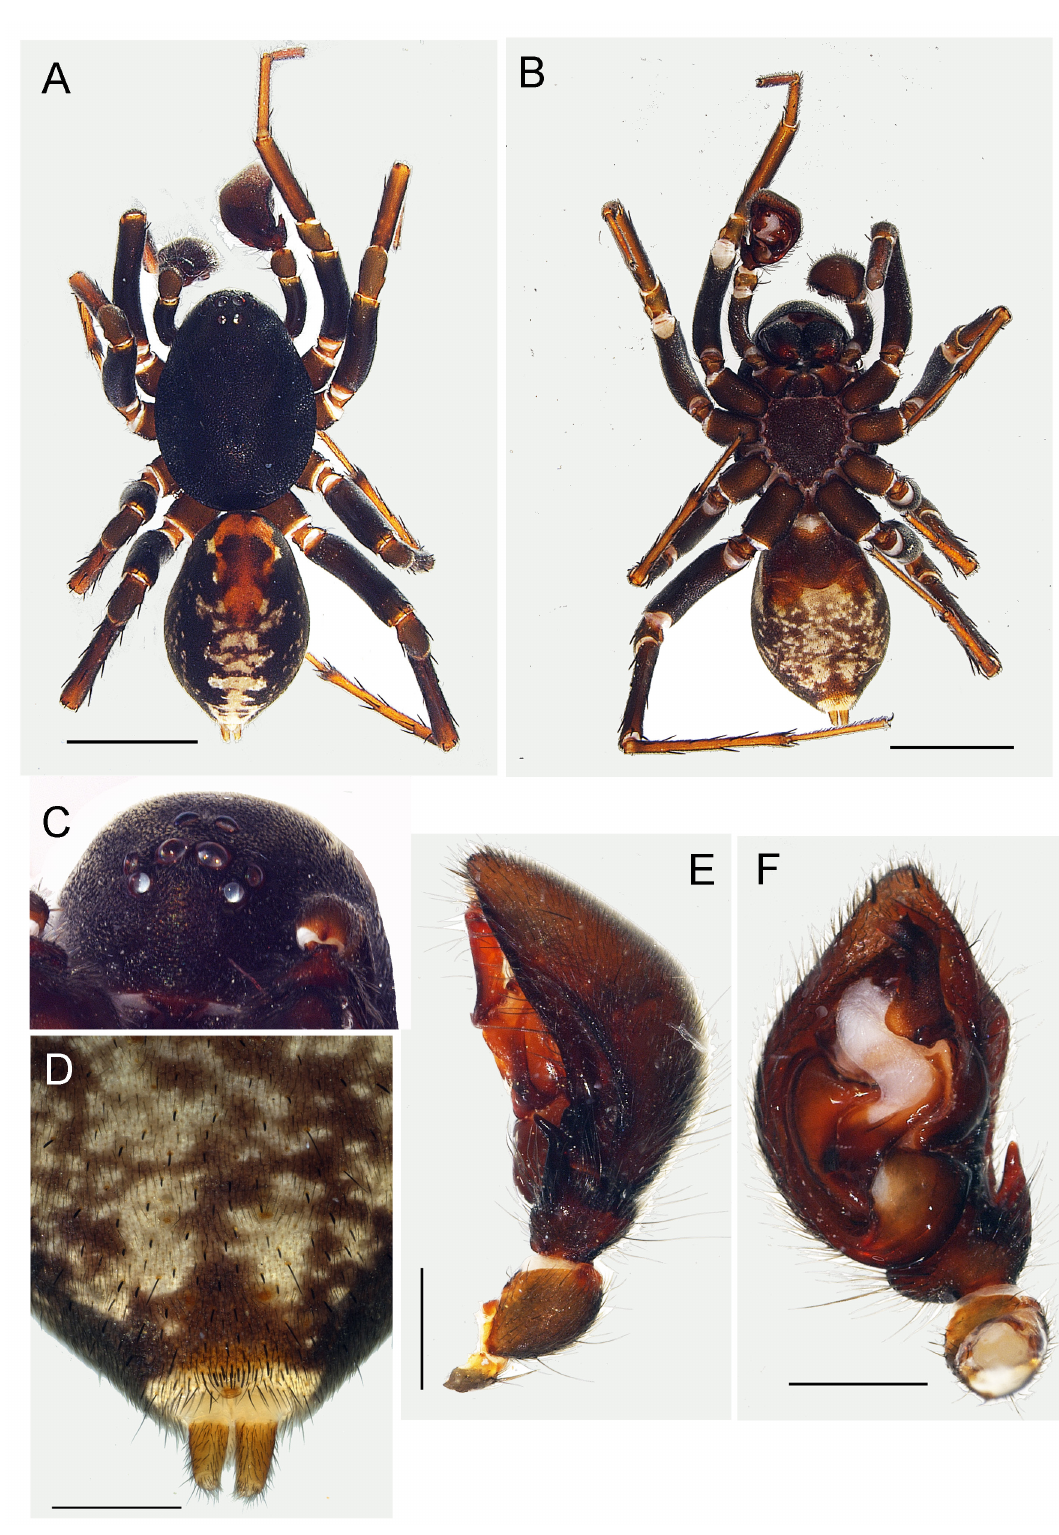
Fig. 5. Cambonilla securicula Jocqué gen. et sp. nov., male holotype. A . Habitus, dorsal view. B . Habitus, ventral view. C . Carapace, frontal view. D . Abdomen, posterior part, ventral view. E . Male palp, retrolateral view. F . Male palp, ventral view. Scale bars: A–B = 2 mm; C = 1 mm; D–F = 0.5